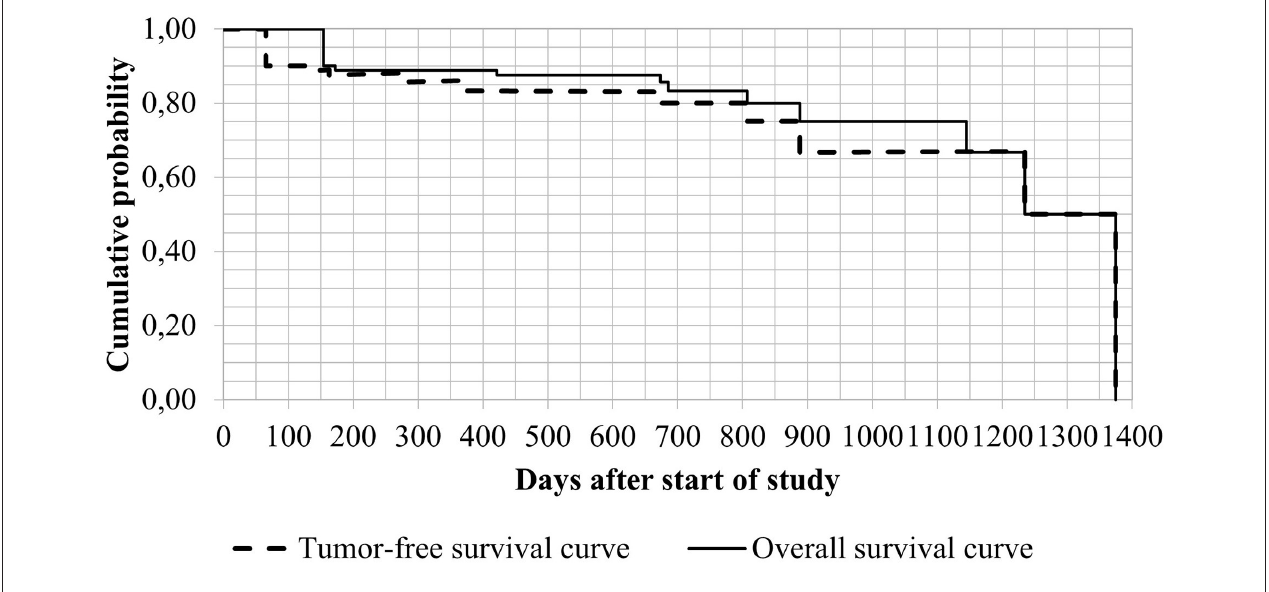
FIGURE 1 | Kaplan-Meier survival curves of patients treated with 2-AEH2F.